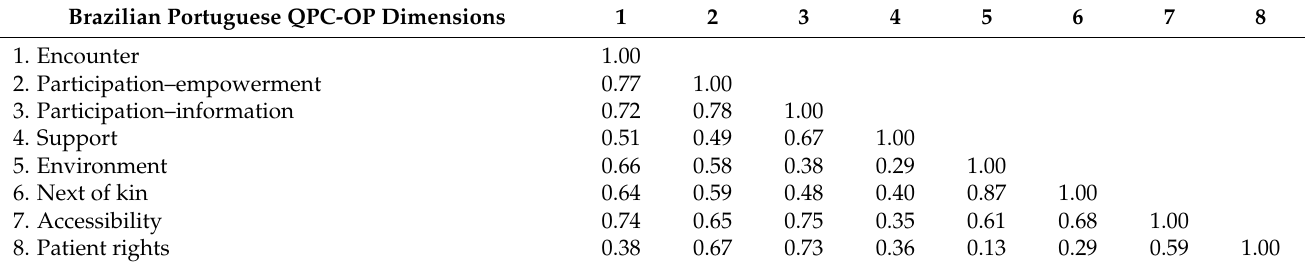
Table 3. Correlation coefficients of the Brazilian Portuguese QPC-OP dimensions ( n = 253) #